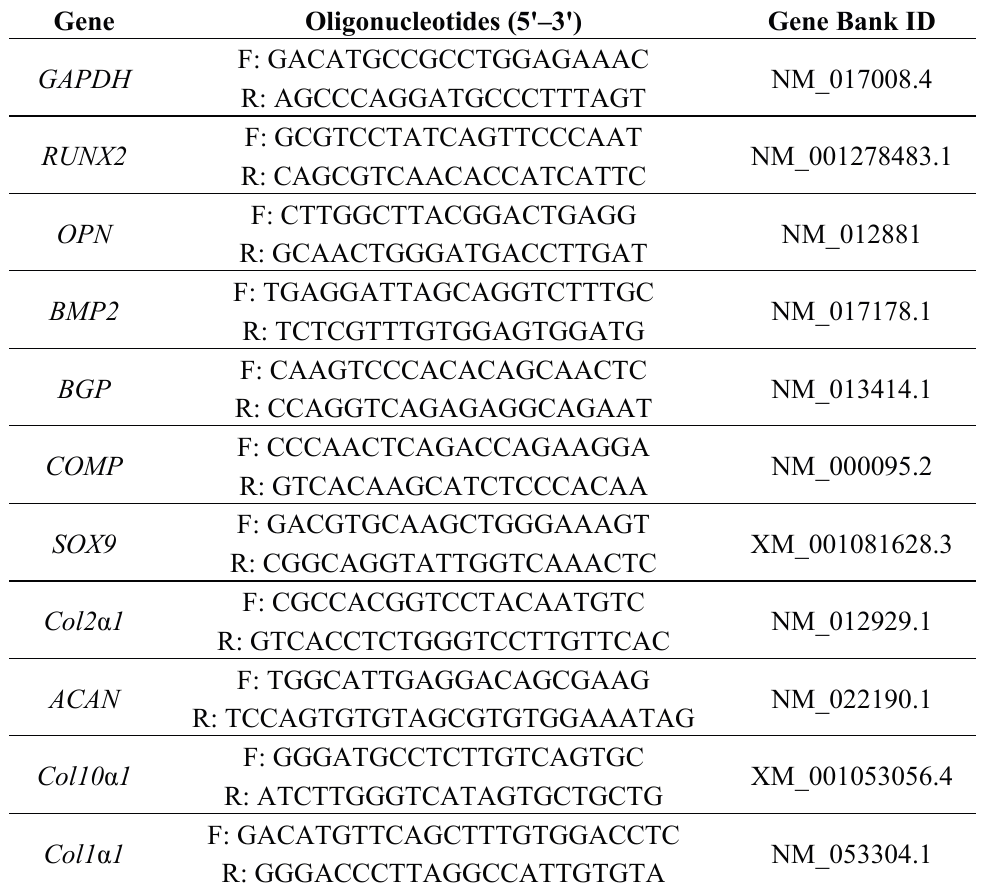
Table 1. Primer oligonucleotide sequences in this